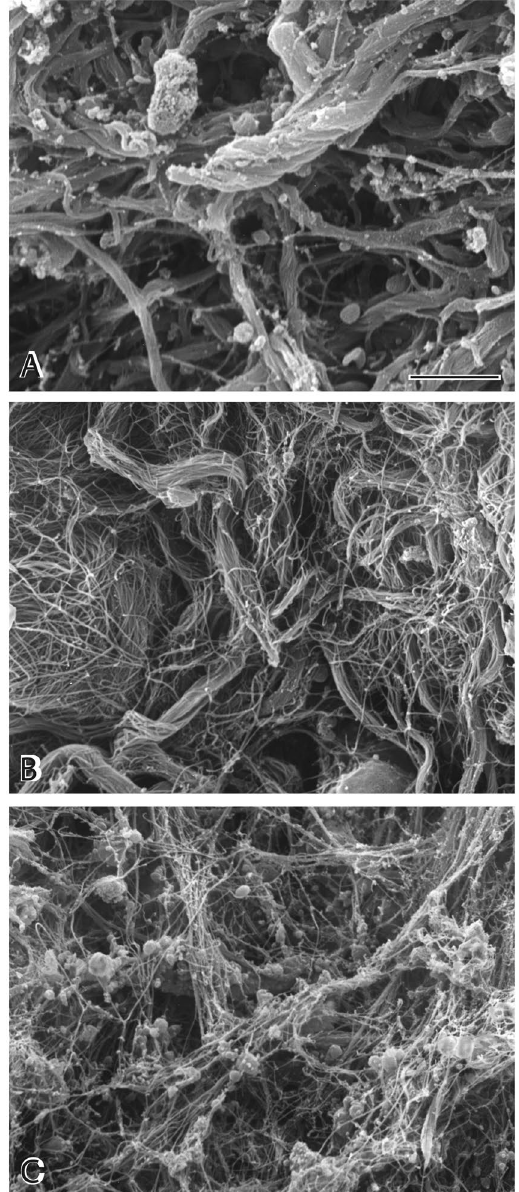
Figure 3. Fibrin structures in thrombi. There was great diversity in the structure of fibrin in thrombi and emboli. ( A ) Very thick bundles of fibers that are sometimes twisted with large pores. ( B ) Thick bundles of fibers made up of thinner fibers and large pores. ( C ) Thrombus with a non-uniform distribution of thin fibers with large pores and platelet aggregates and fragments. Magnification bar = 1 µ